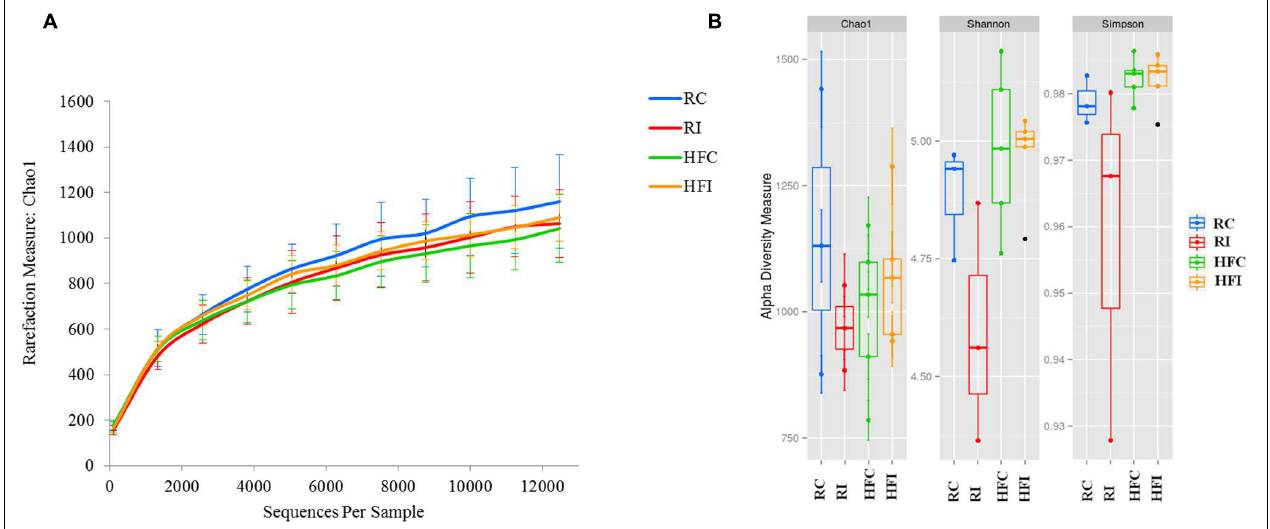
FIGURE 5 | Sacculus rotundus diversity analysis. (A) Sacculus rotundus rarefaction curve generated using Chao1 richness estimator. Samples have been rarified at an even depth of 12,400 sequences per sample. Error bars indicate the 95% confidence intervals. (B) Sacculus rotundus alpha-diversity; richness (Chao1) and diversity (Shannon and Simpson) indices box plot.